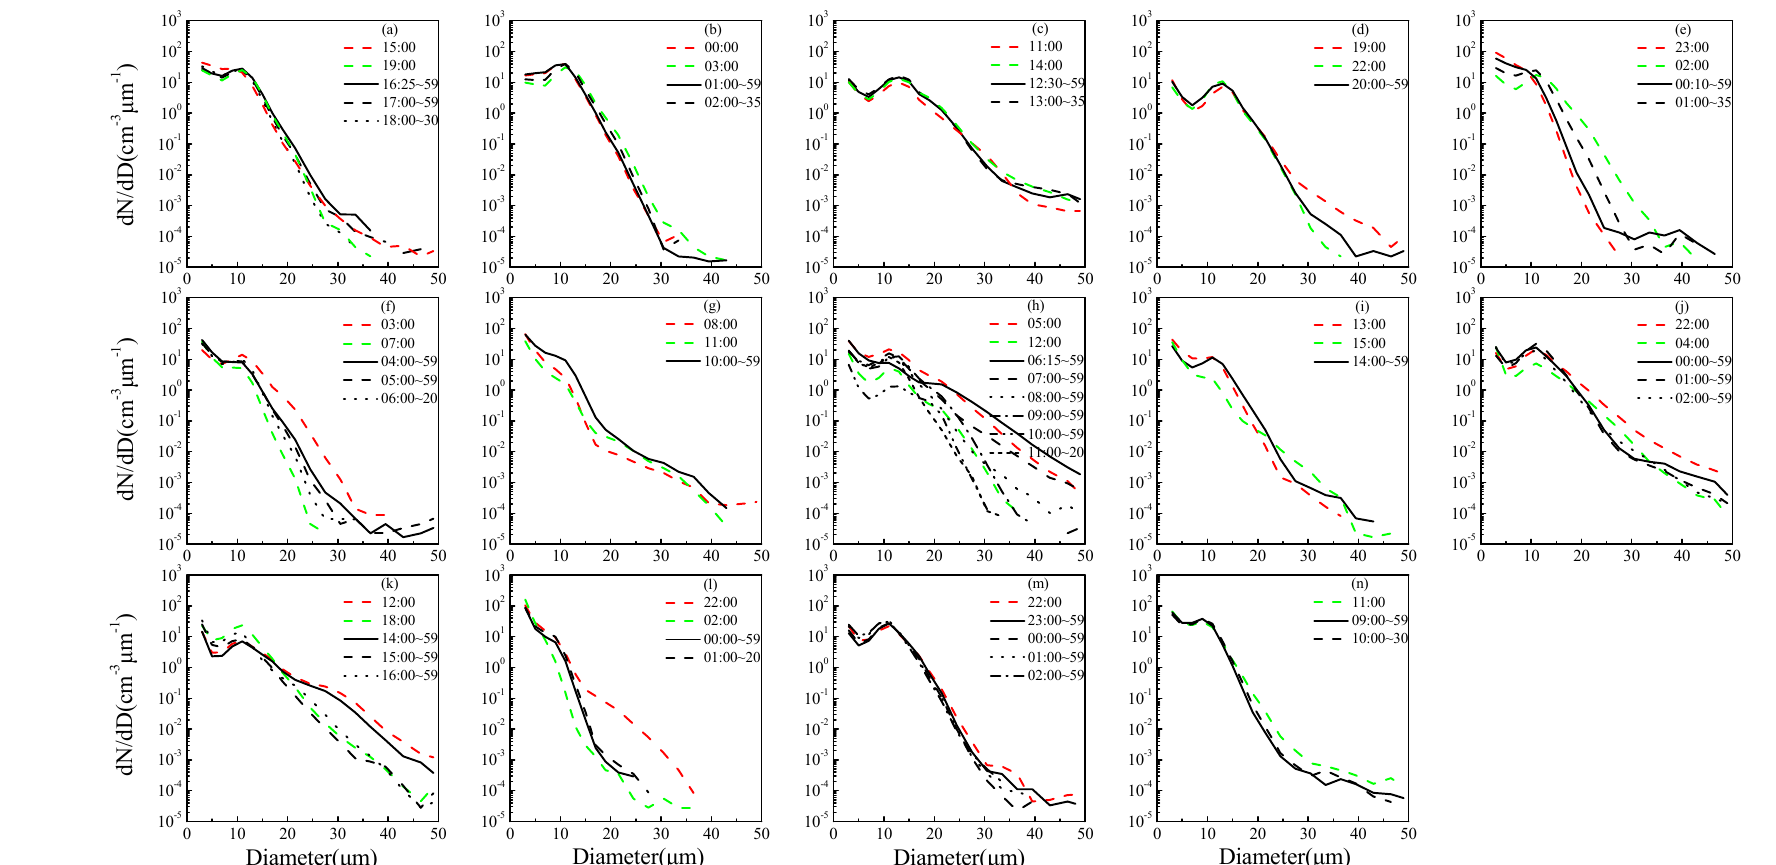
Figure 4. Temporal evolution of fog spectra based on one-hour-average data in cases 1–14 and one hour before/after. ( a ) Case1; ( b ) case2; ( c ) case3; ( d ) case4; ( e ) case5; ( f )